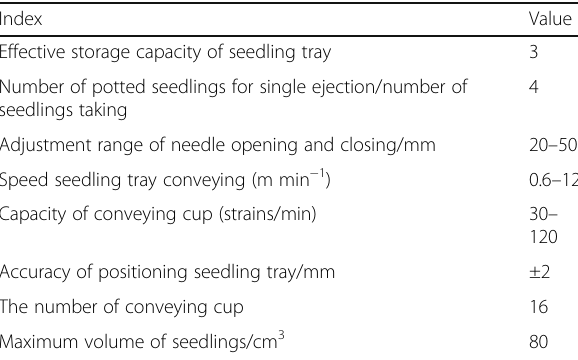
Table 1 Key performance indicators of automatic conveying system for vegetable seedlings